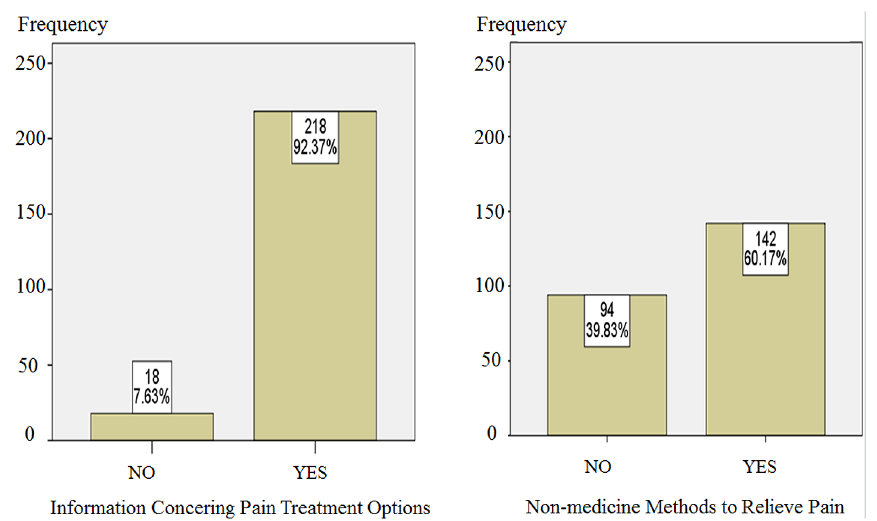
Fig 1. Distribution of receivedinformation and treatment selection in the enrolled patients. There are 92.37%of the patients received information about pain treatment options, and 60.17% of patients selected non-pharmacologicalmethods to relieve